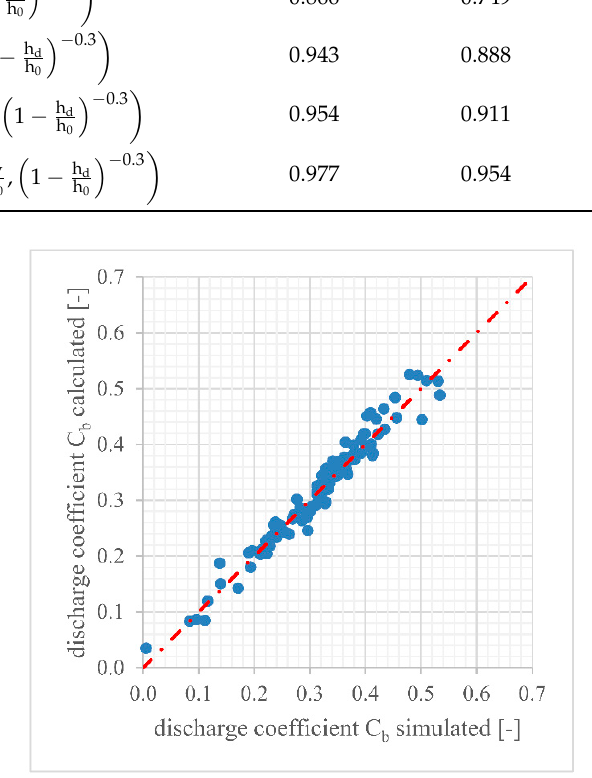
Figure 12. Comparison of the simulated and calculated discharge coefficients C b .